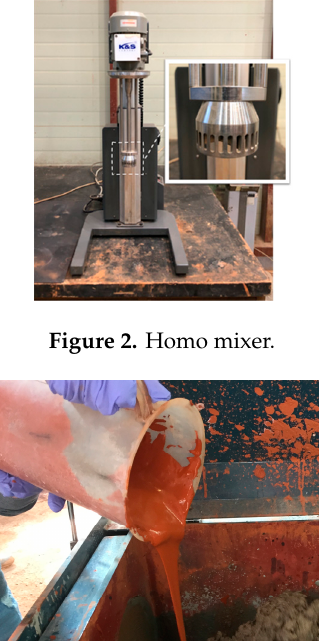
Table 4. Physical properties and chemical composition of cement.